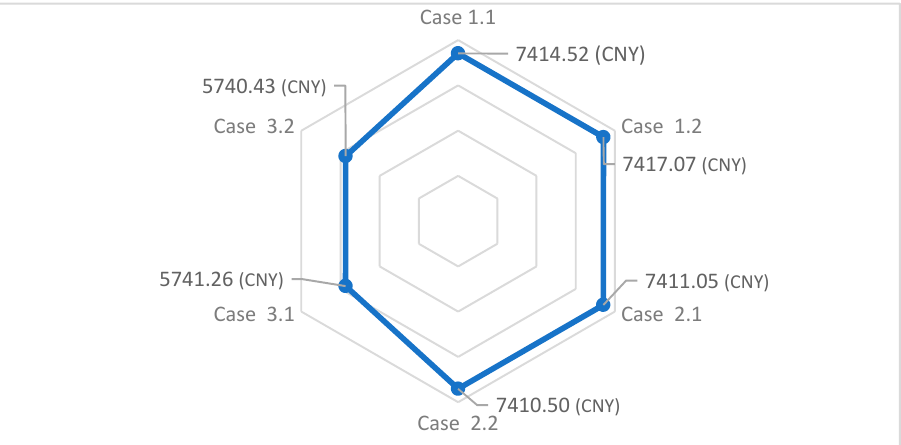
Figure 7. All costs in the different cases.